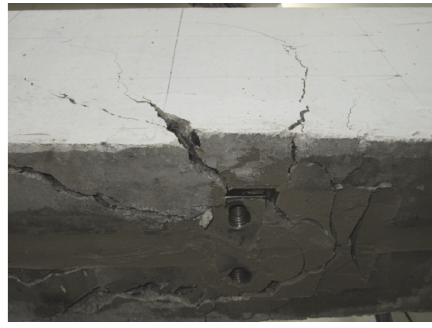
Figure 7: Cracking of anchor plate (SL70-E-40).